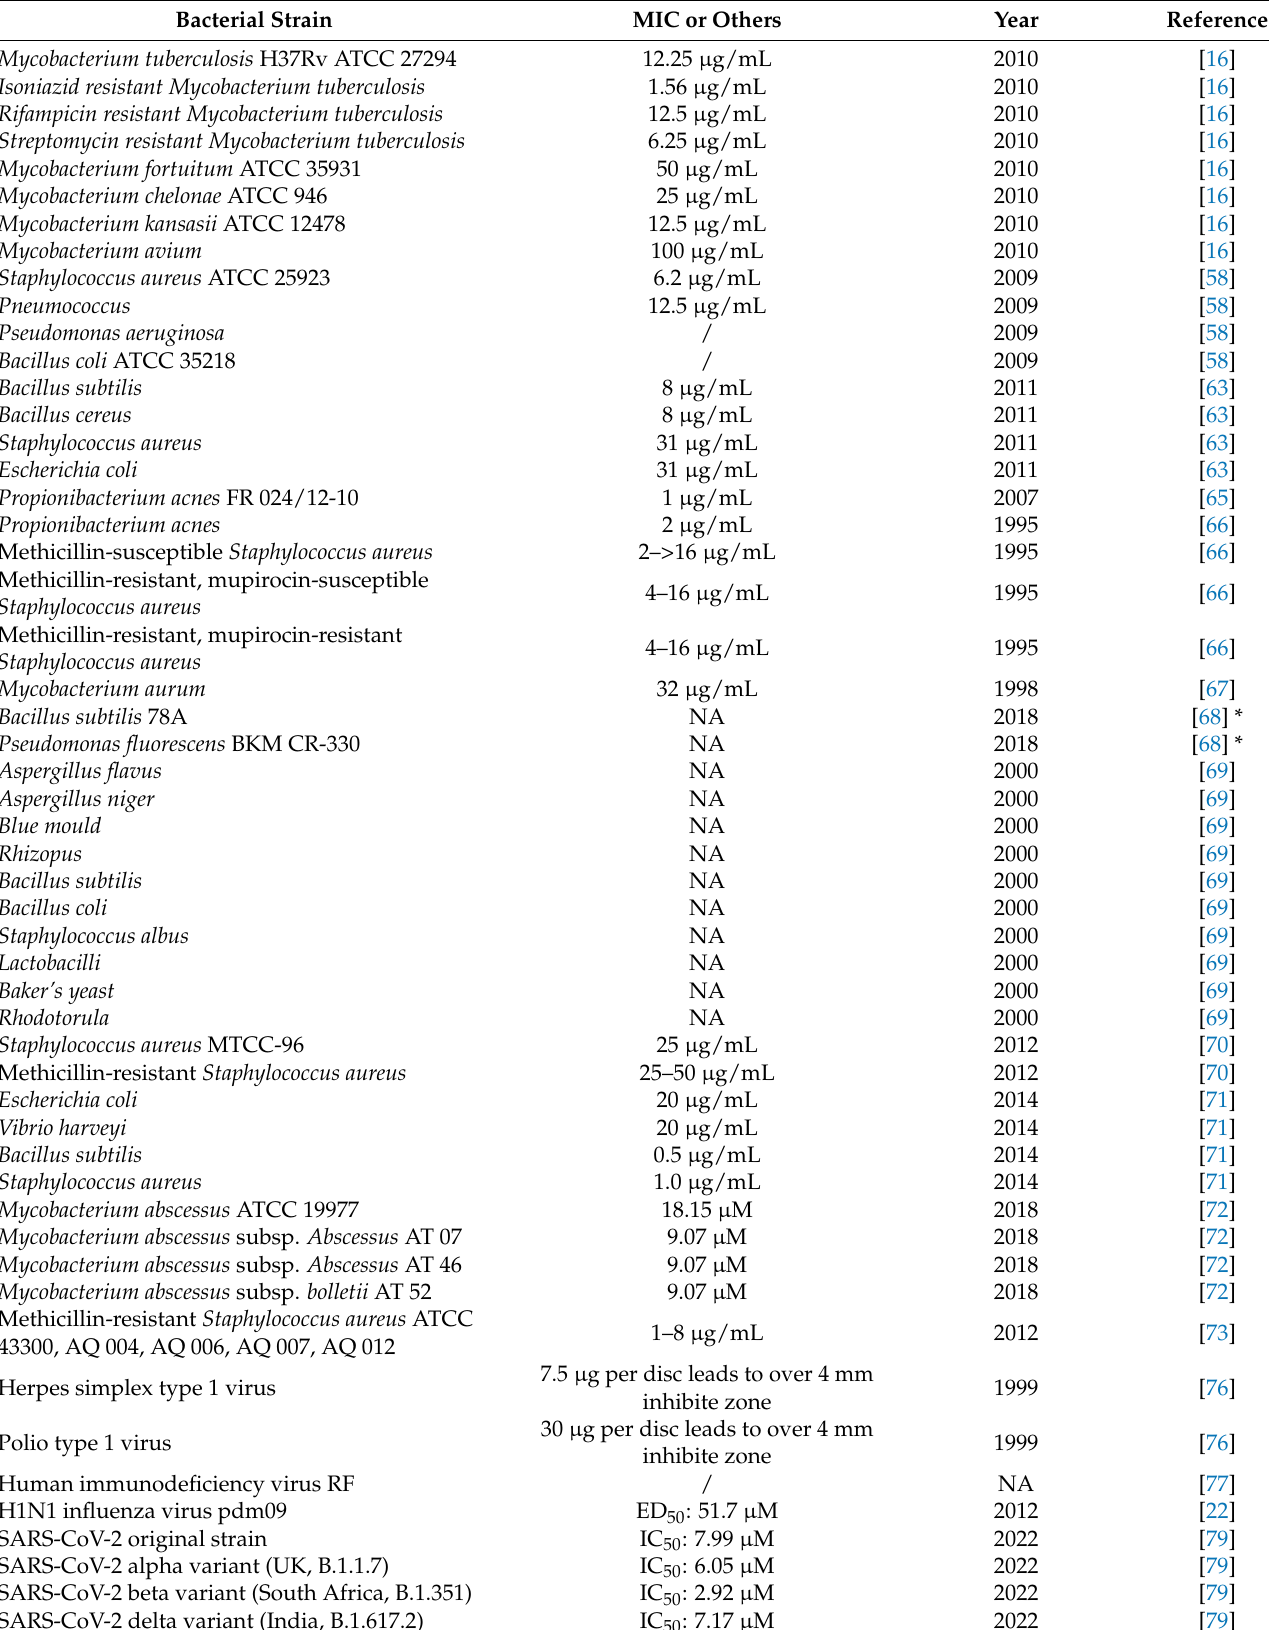
Table 2. Antibacterial and antiviral activities of usnic acid.